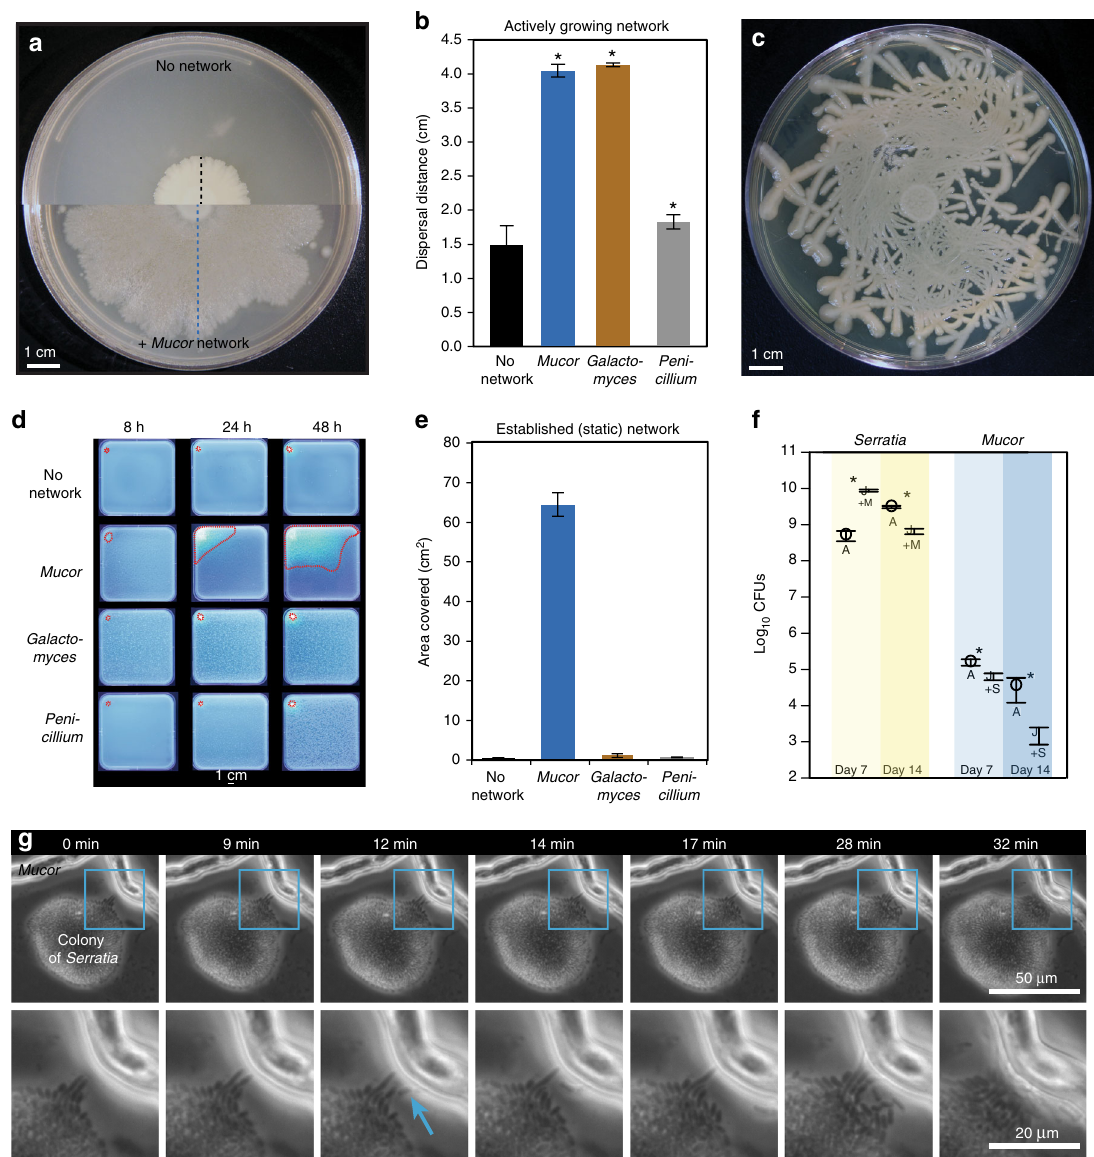
Fig. 2 Macroscopic and microscopic characterization of Serratia proteamaculans dispersal on fungal networks. a Dispersal of Serratia on PCAMS agar without Mucor (top) and with Mucor (bottom). The black dashed line indicates dispersal distance alone and the blue dashed line indicates dispersal distance with a Mucor network (as displayed in Fig. 2b). b Serratia dispersal distance after 14 days of growth. Bars show mean distance from the center of the spot to the bacterial colony edge ( ± 1 standard deviation, n = 5). Asterisks indicate signi fi cant differences in dispersal compared to control (Dunnett ’ s test, p < 0.05). c Dispersal of Serratia along a synthetic fungal network made of glass fi bers placed on PCAMS agar. d Representative time-lapse images after 8, 24, and 48 hours of GFP-tagged Serratia dispersing with no network or on an already established (static) network of Mucor , Galactomyces , or Penicillium on PCAMS agar. The outermost edges of the area where Serratia spread on each fungal network are outlined in red dashed lines. Each square Petri dish is 12 cm × 12 cm. e Serratia dispersal distance with no network or on an established (static) network of Mucor , Galactomyces , or Penicillium . Bars show the mean area covered ( ± 1 s.d., n = 3). Area traveled on Mucor was signi fi cantly higher than the other fungal networks based on an ANOVA with a Tukey ’ s post hoc test ( F 3,15 = 1788, p < 0.0001). f Serratia and Mucor growth, as measured by total colony forming units (CFUs), alone and in combination, after 7 and 14 days ( n = 5). Asterisks indicate signi fi cant differences between Alone (A) and + Mucor / Serratia (+M/+S) (Student ’ s t -test, p < 0.05). g Time lapse of Serratia – Mucor interaction over 32 minutes. The full colony of Serratia is shown in the top row, with two Mucor hyphae at the top. The bottom row is a zoomed-in section (outlined in blue) showing a close-up of pioneer Serratia cells colonizing the Mucor hyphae, indicated by the blue arrow.